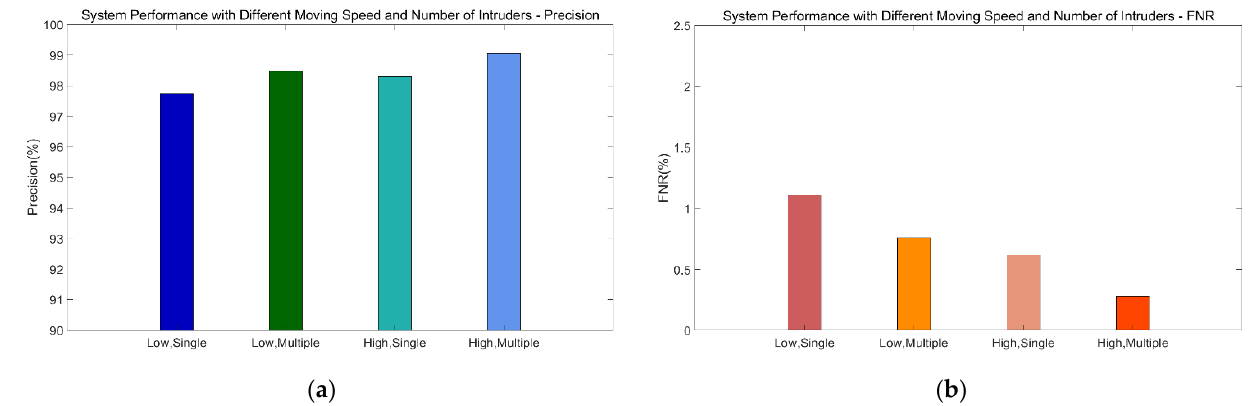
Figure 20. System performance with different speed and intruders. ( a ) Precision. ( b ) FNR.